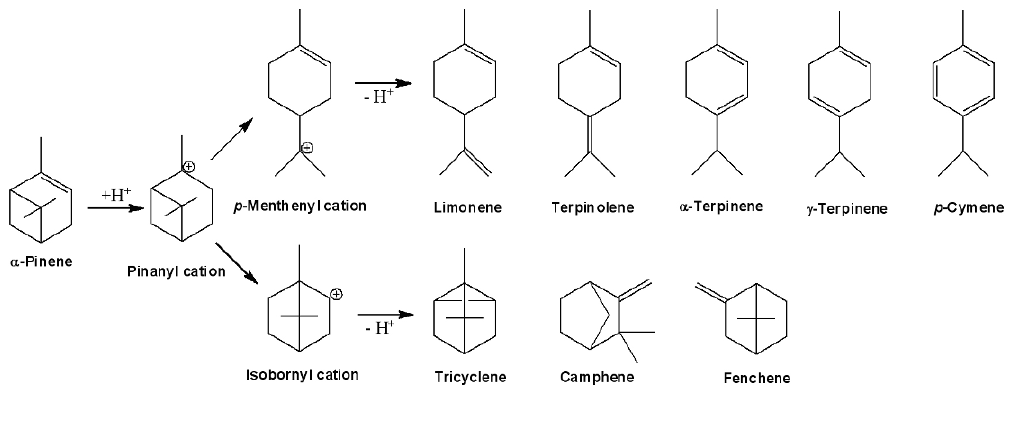
Scheme 1. Acid-catalyzed isomerization of α -pinene. Table 2. Distribution of the products for isomerization of α -pinene over the catalyst (20 g α -pinene, 0.2 g catalyst). Catalyst Composition (% mole) α -Pinene Tricyclene Fenchene